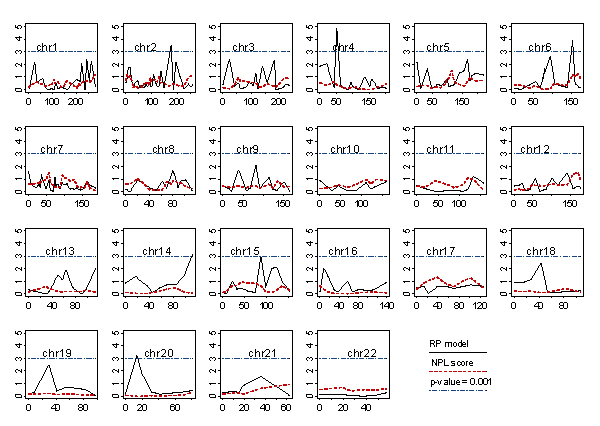
-log10(p-values) of NPL score and of the RP model.